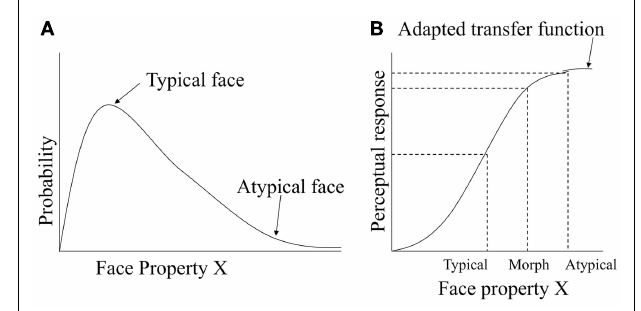
FIGURE 7 | Information maximization account of atypicality bias. (A) Probability density function for typical and atypical faces. (B) Perceptual response for typical, atypical and the typical-atypical morph faces as predicted by adaptive transfer